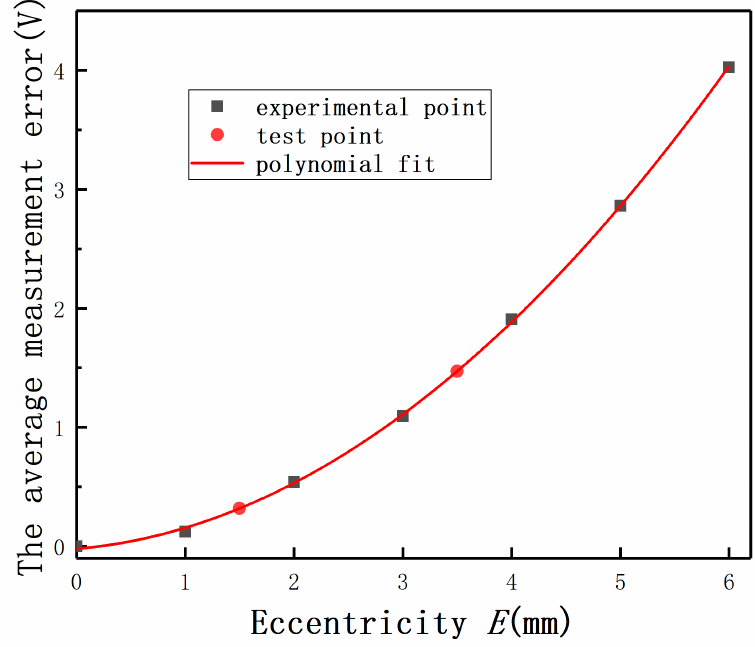
Figure 16. The average measurement errors with different eccentricities.